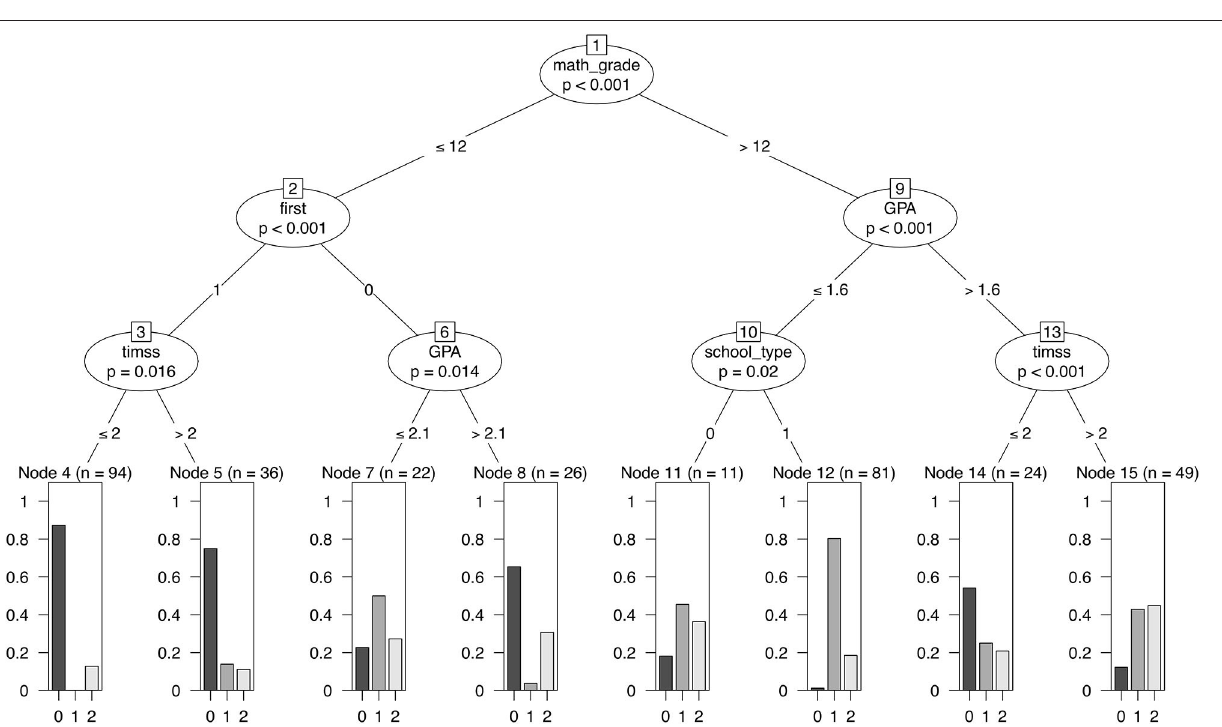
FIGURE 2 | Conditional inference tree for the group membership of correct positive predictions, correct negative predictions and wrong predictions. The figure shows the split-points within the features used for splits. In the terminal nodes 4, 5, 7, 8, 11, 12, 14, and 15 the frequencies of the group membership are shown, with group 0 being the true negative predictions, group 1 the true positive predictions and group 2 the wrong predictions. The risk group is defined as the true negative predictions. The terminal nodes 4, 5, 8, and 14 are assigned to this group. Predicted outcomes of the ensemble predictor for the complete dataset dataC are